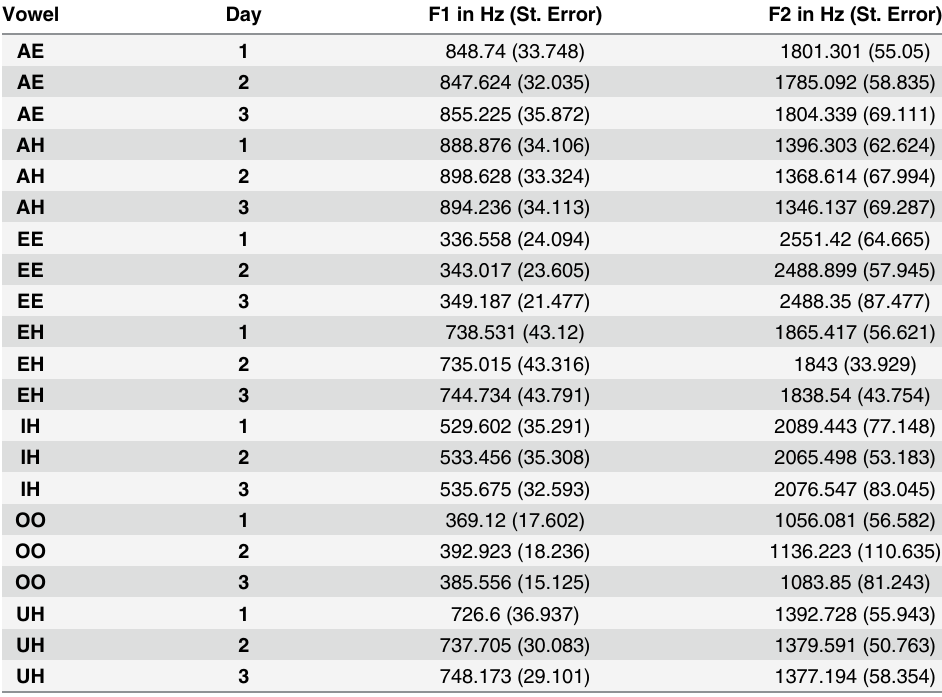
Table 1. F1 and F2 average values and associated standard error (in Hz) for each vowel for the three days tested. Vowel Day F1 in Hz (St. Error) F2 in Hz (St.